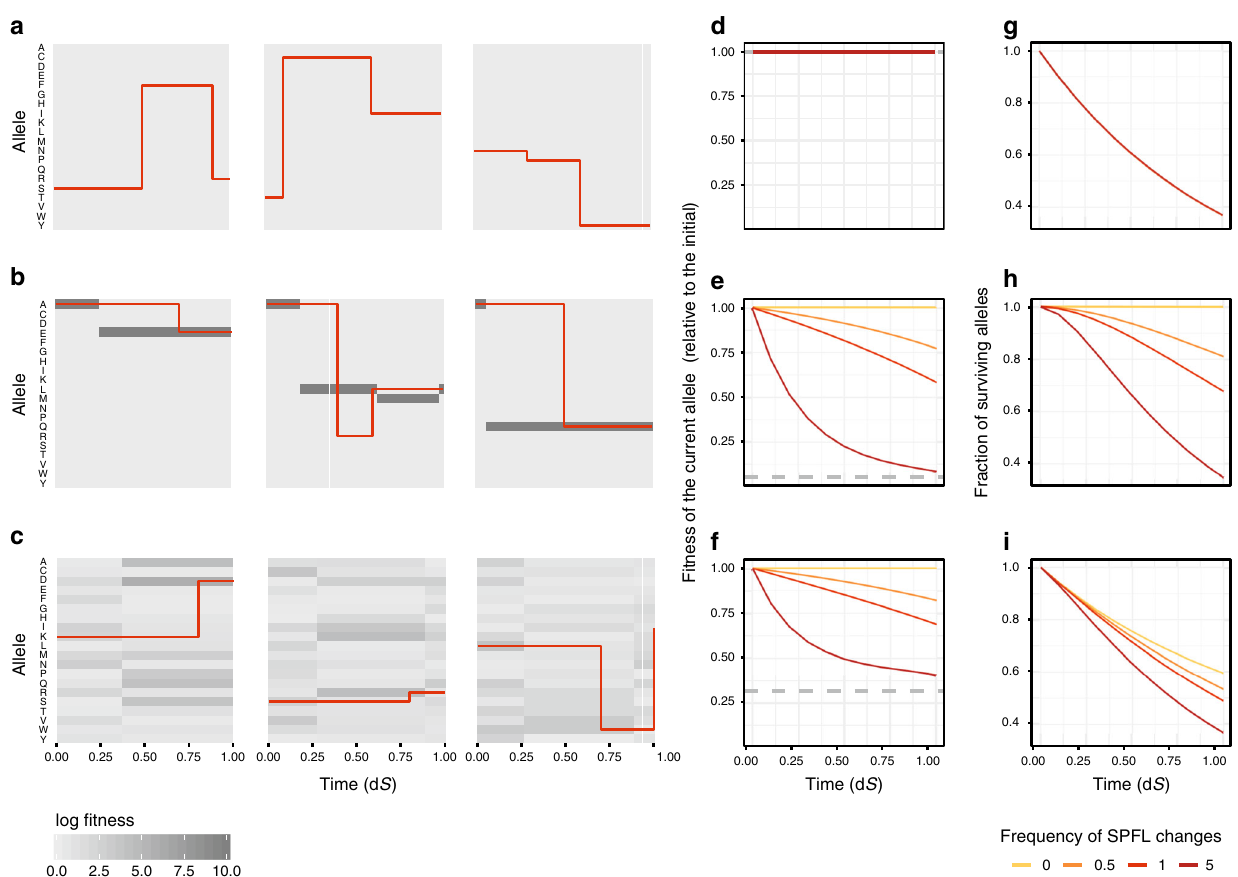
Fig. 1 Random changes of SPFL reduce the fi tness of the current allele. a – c Examples of how simulated random changes in SPFLs of different shapes provoke allele substitutions. Each of the nine plots shows the history of one simulated amino acid site; red lines represent the current allele at the site, with vertical red lines indicating substitutions. SPFL changes randomly at the average rate of one change per time required for one neutral substitution (1 dS). a All 20 possible alleles have the same fi tness ( fl at SPFL), so that all substitutions are neutral. b One allele is substantially more bene fi cial than others (rugged SPFL, log fi tness vector = [10, 0, ..., 0]); most of the observed substitutions are positively selected. c Log fi tness values are drawn from a gamma distribution with shape and rate = 1. d – f Changes in the average fi tness of the current allele with evolutionary time under random SPFL changes. If the SPFL is static (frequency of SPFL changes = 0), the fi tness of the current allele remains constant. The same is true for the fl at landscape ( d ). Otherwise, the fi tness of the current allele declines for both the rugged ( e ) and the gamma-distributed ( f ) SPFLs, i.e., the current allele undergoes senescence, and the more frequently the SPFL changes, the more rapid is this decline. The mean fi tness across all possible alleles is shown with a dashed line. g – i The fraction of surviving ancestral alleles as a function of time since the beginning of the simulation. For both the rugged ( h ) and the gamma-distributed ( i ) SPFLs, random changes in the landscape increase the rate at which the original allele is lost ( h , i ), unless the SPFL is fl at ( g ). For d – i 95% con fi dence bands based on ten repeats are plotted (but too narrow to